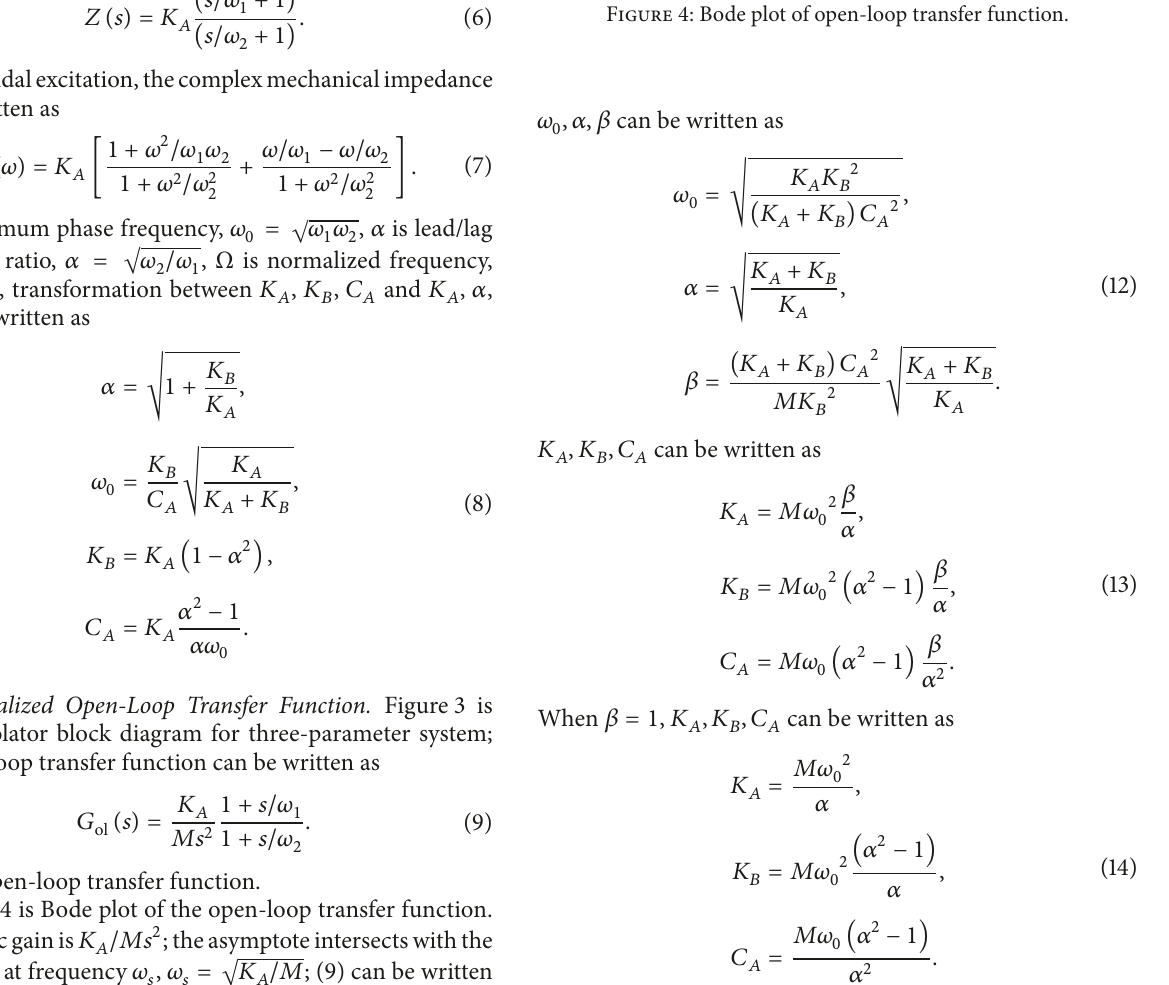
Figure 4: Bode plot of open-loop transfer